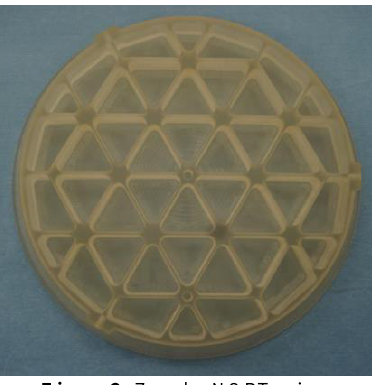
Figure 2: Zerodur NOPT